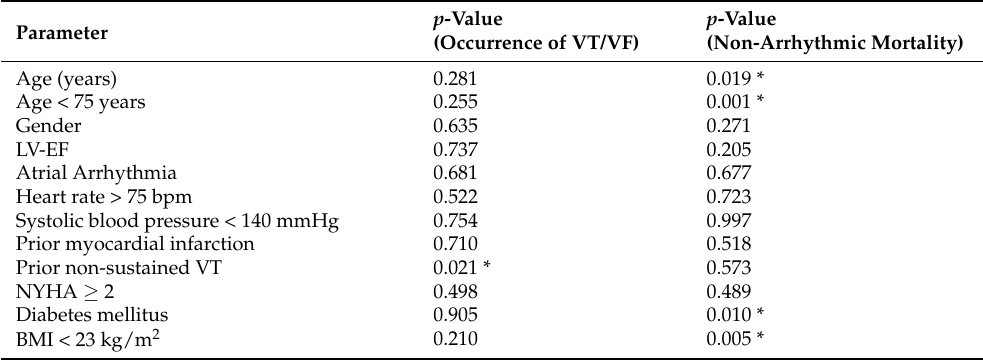
Table 2. MADIT-ICD benefit score parameters as predictors for the occurrence of VT/VF in the whole cohort.